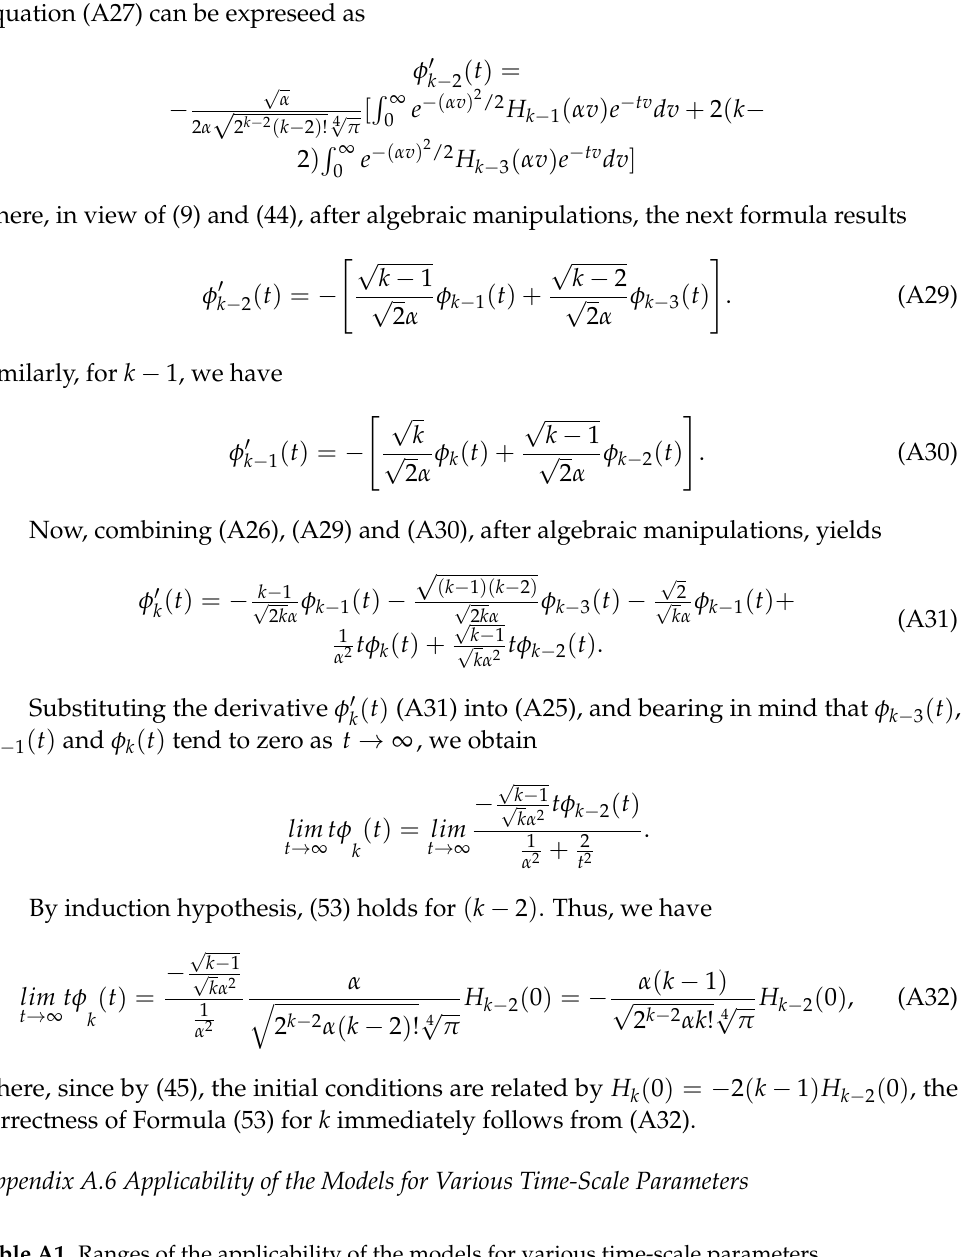
Table A1. Ranges of the applicability of the models for various time-scale